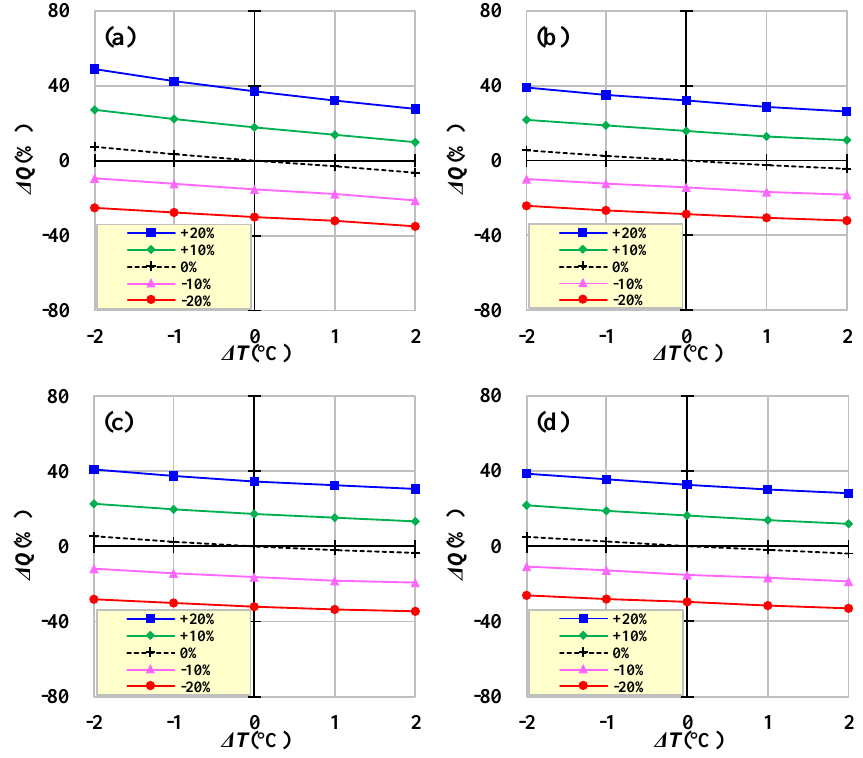
Figure 9. Sensitivity on mean streamflow due to mean temperature change in JRB: Zhimenda ( a ); Shigu ( b ); Panzhihua ( c ); and Huatan ( d ).